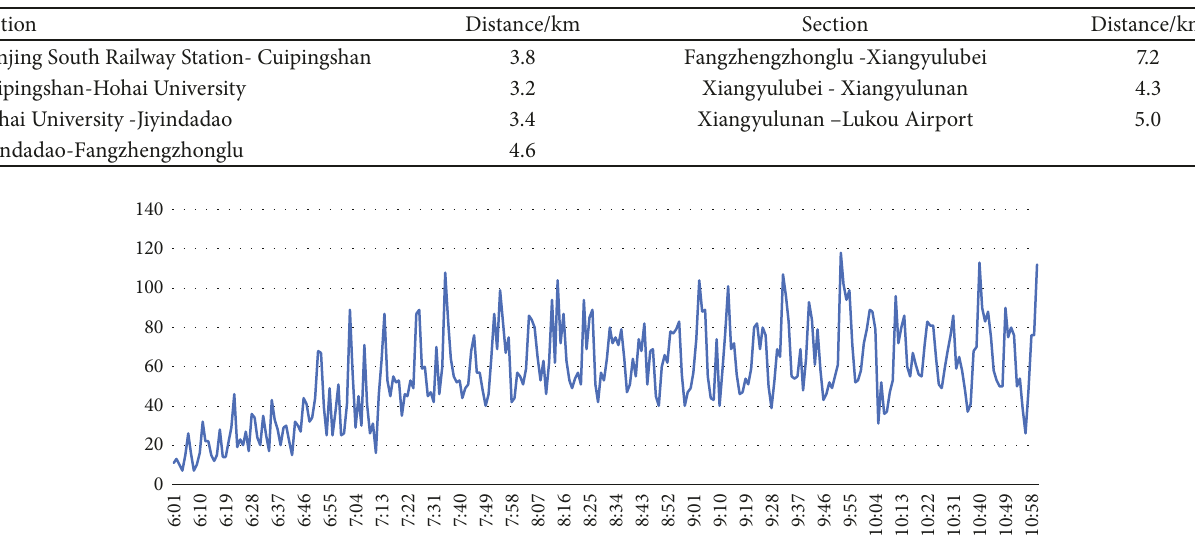
Table 1: Distance of each section in line S1.